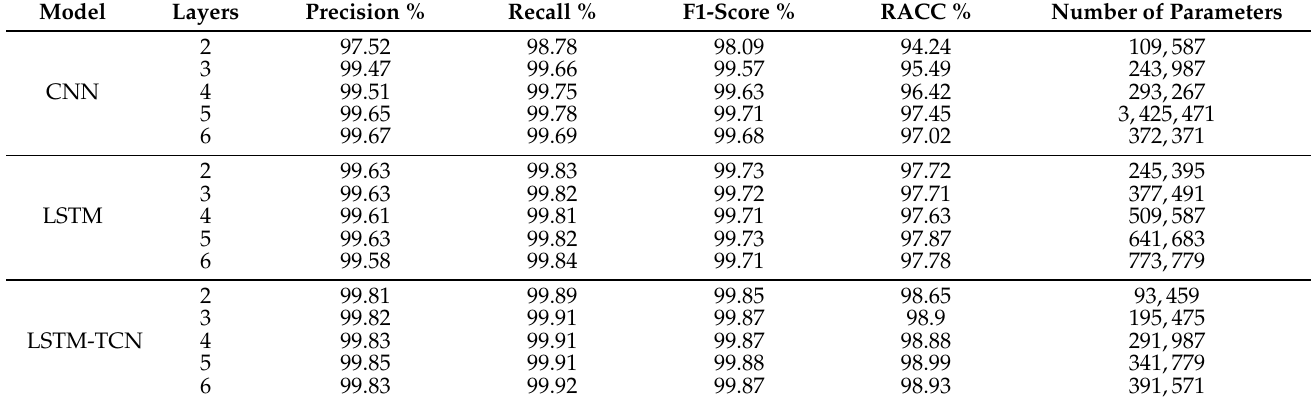
Table 2. Performance evaluation of the IEEE 14-bus power system under L 2 -norm = 2.